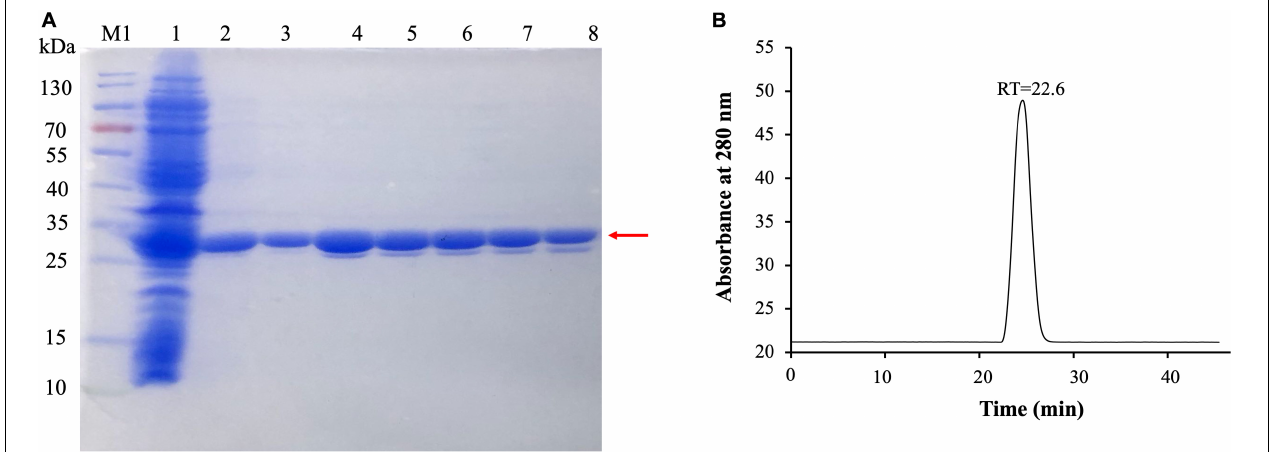
FIGURE 2 | (A) SDS-PAGE of the expression and purification of (VIBVN)NAT in E. coli BL21(DE3) cells. Detailed legend: Lane M1: Protein marker. Lane 1: Supernatant after cell lysate centrifugation (loading). Lane 2: Flowthrough with 50 mM Tris–HCl, 150 mM NaCl, and 20 mM imidazole (pH 8.0). Lanes 3–5: Elution with 50 mM Tris–HCl, 150 mM NaCl, and 40 mM imidazole (pH 8.0). Lane 6–8: Elution with 50 mM Tris–HCl, 150 mM NaCl, and 200 mM imidazole (pH 8.0). Molecular weight determination by using SDS-PAGE. (B) Gel filtration chromatography analysis of (VIBVN)NAT. The enzyme was prepared at a concentration of 5 mg/mL in PBS buffer. Approximately 100 µ l of the sample was injected onto the column. The relative amount of the main form of the enzyme (retention time (RT) = 22.6 min) was present in the sample.